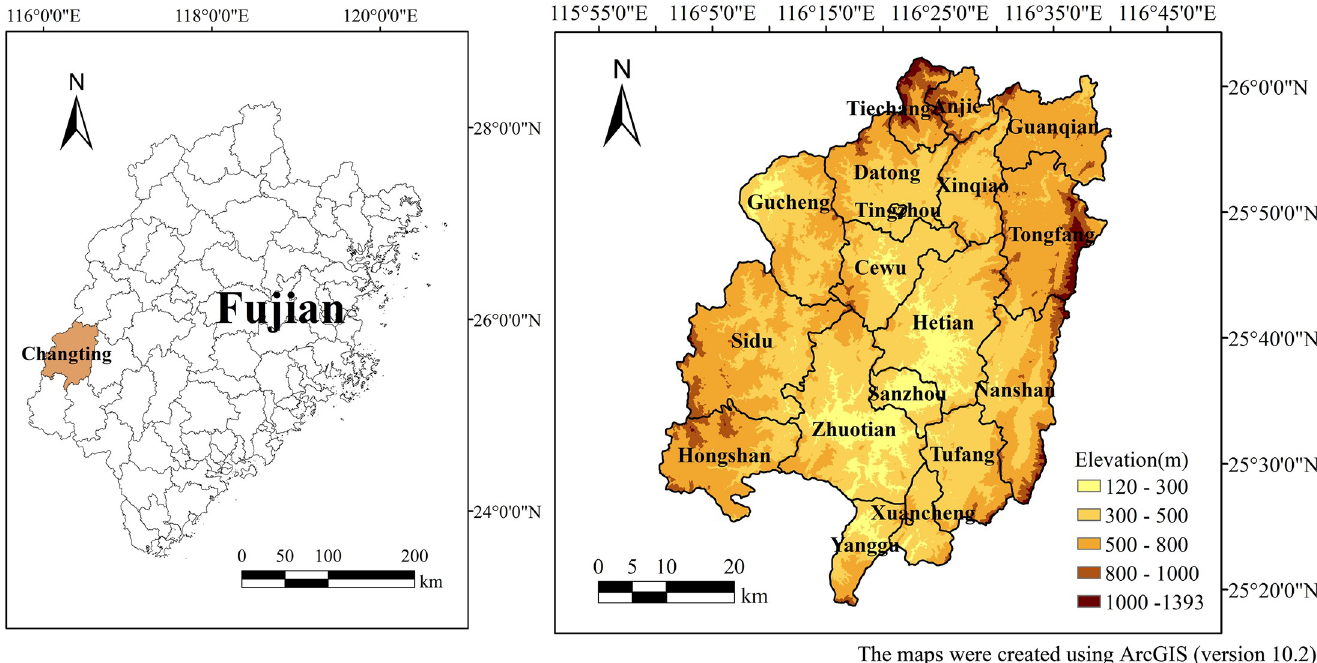
Fig 1. Location and elevation of Changting County, Fujian.